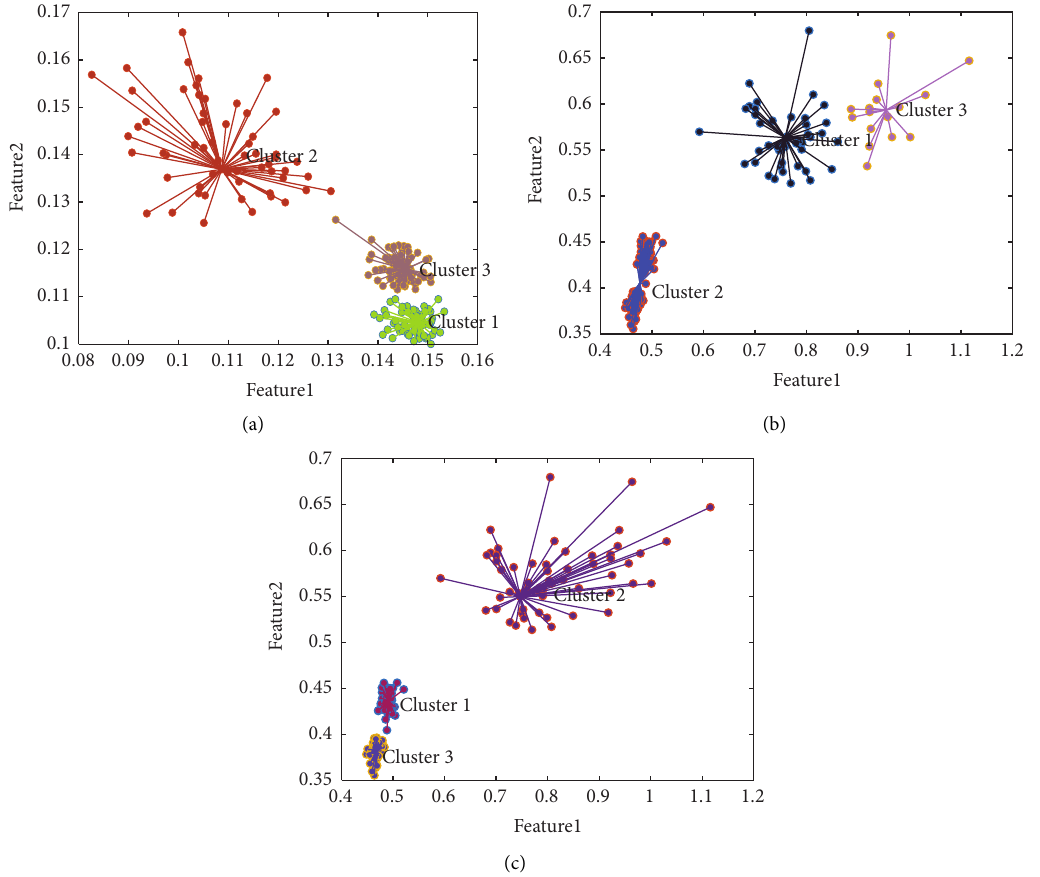
Figure 11: Cluster result of the CWRU data sets. (a) ATDPS; (b) K-means; (c) AP.